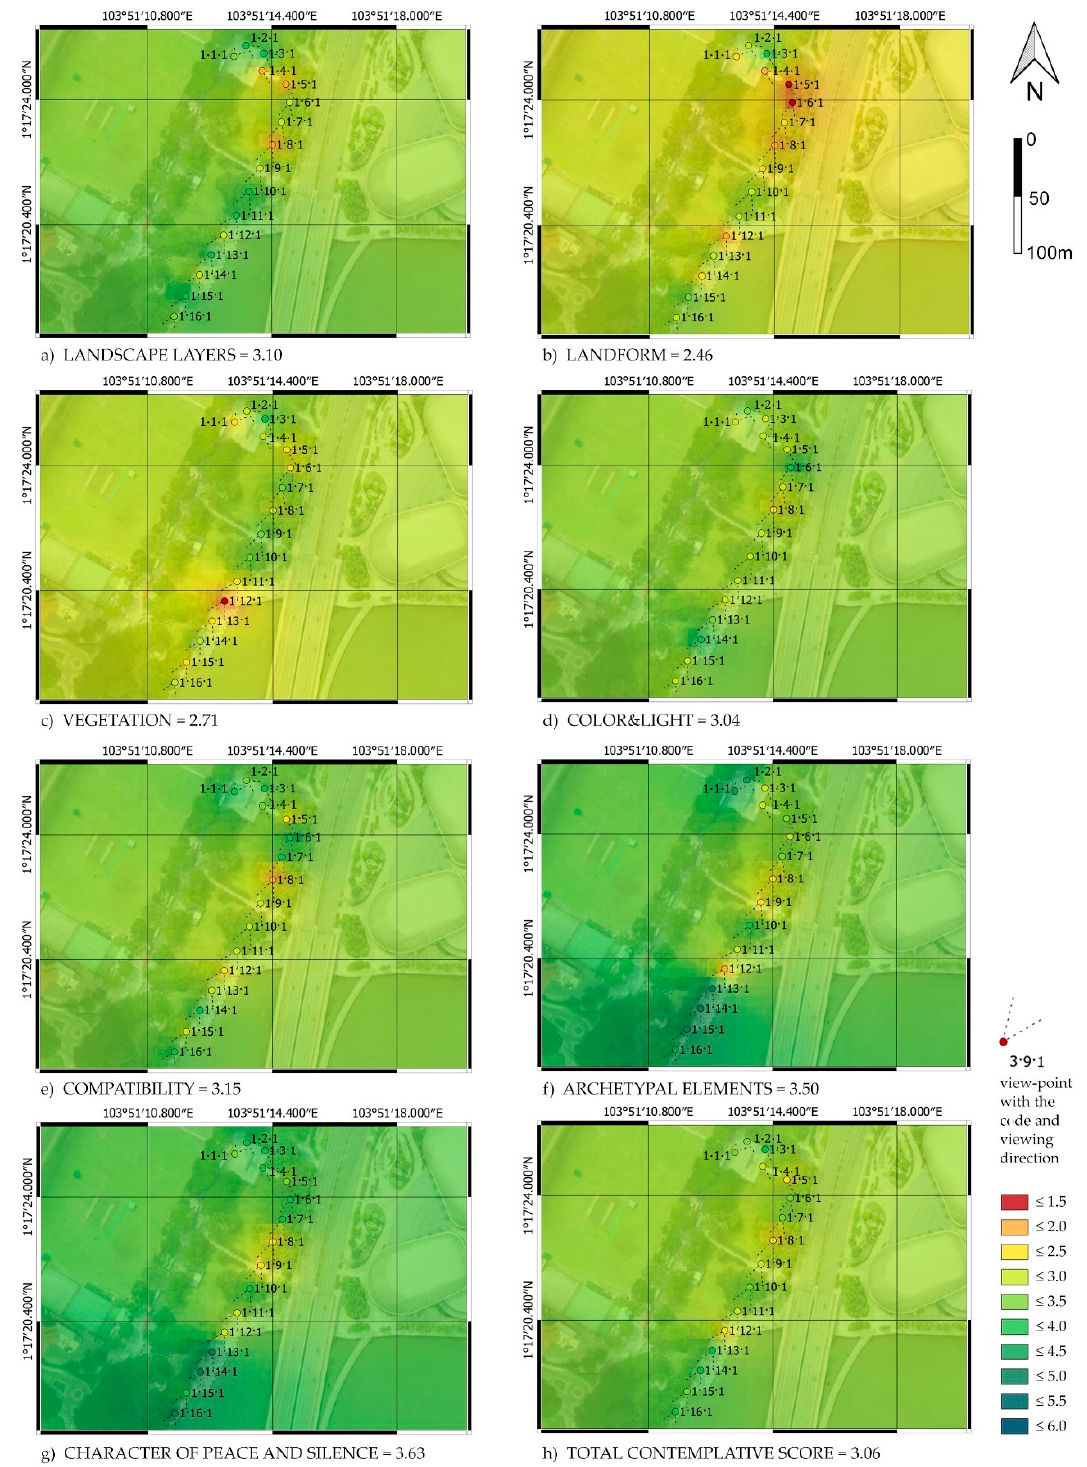
Figure 7. Result maps of contemplative scores along the Path 1–Esplanade Park; walking in one direction from 1 · 1 to 1 · 16.; ( a – g ) maps of each contemplative landscape attribute and ( h ) the total CL score (average of all attributes).